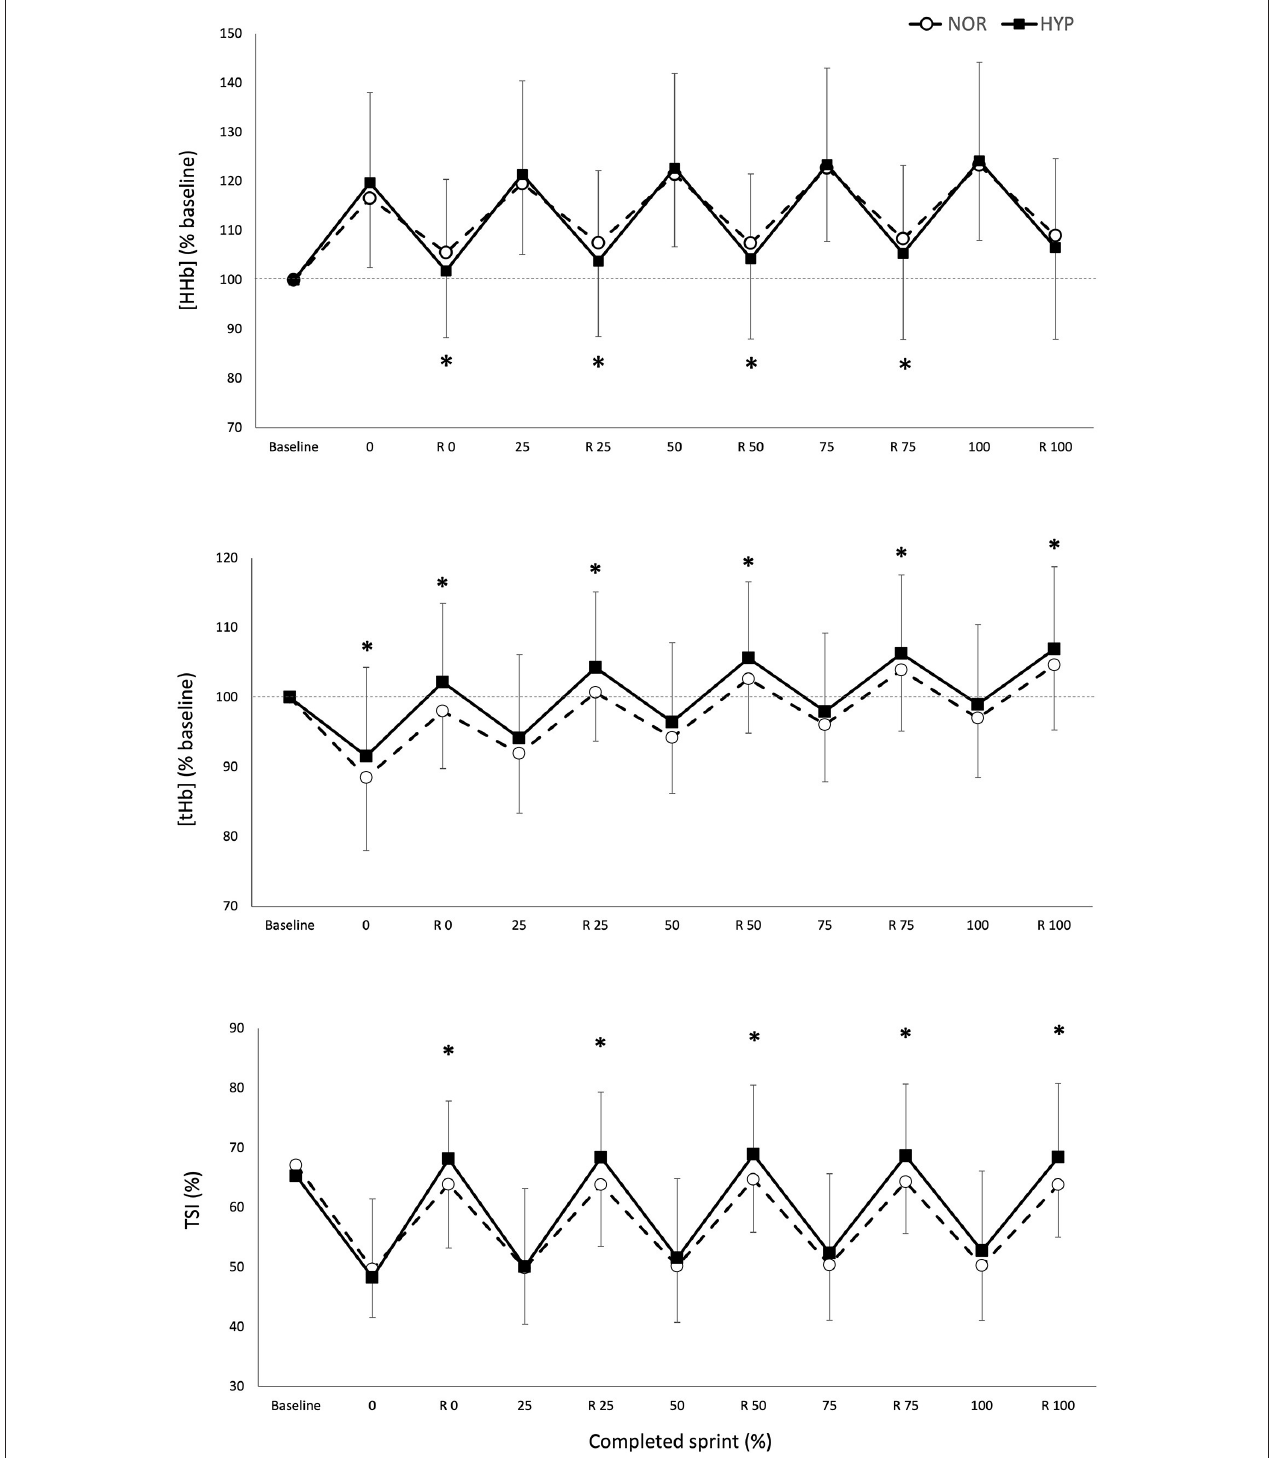
FIGURE 2 | Maximal and minimal values of normalized deoxyhemoglobin/myoglobin concentration [HHb/Mb], total hemoglobin/myoglobin concentration [tHb/Mb], and tissue saturation index [TSI], over the number of sprints and recovery (R) periods for the five relative percentages of test completion in normoxia and hyperoxia (F i IO 2 0.40). Data are presented as means ± SD, expressed as a percent of the baseline. *Small effect between conditions.